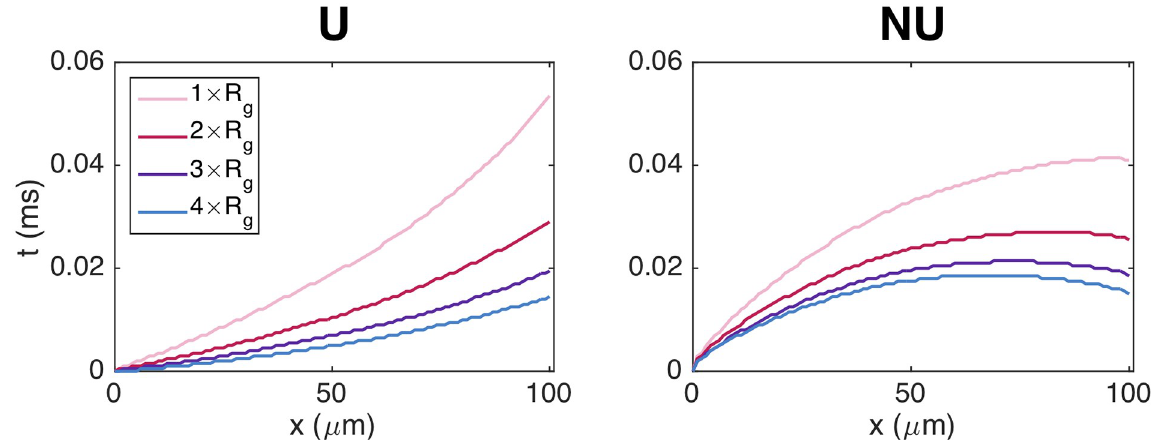
Fig 6. The intracellular activation times are affected by the sodium channel distribution and gap junction resistance. The figure shows the results from Fig 5 zoomed in on the x -values corresponding to a single cell in the center of the